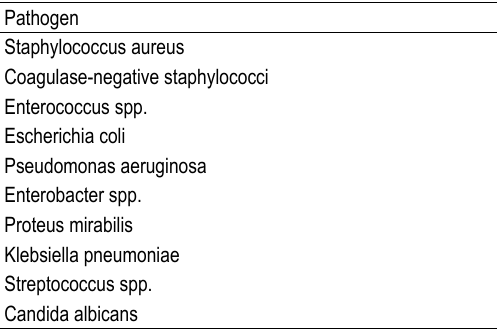
Table 2. causes of surgical wounds